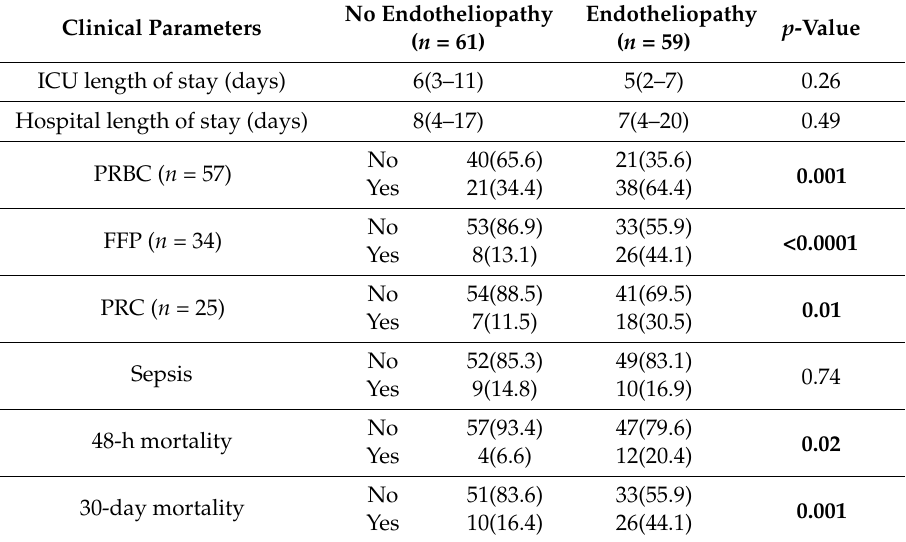
Table 4. Comparisons of clinical outcome with respect to endotheliopathy in patients with/without traumatic brain injury-induced